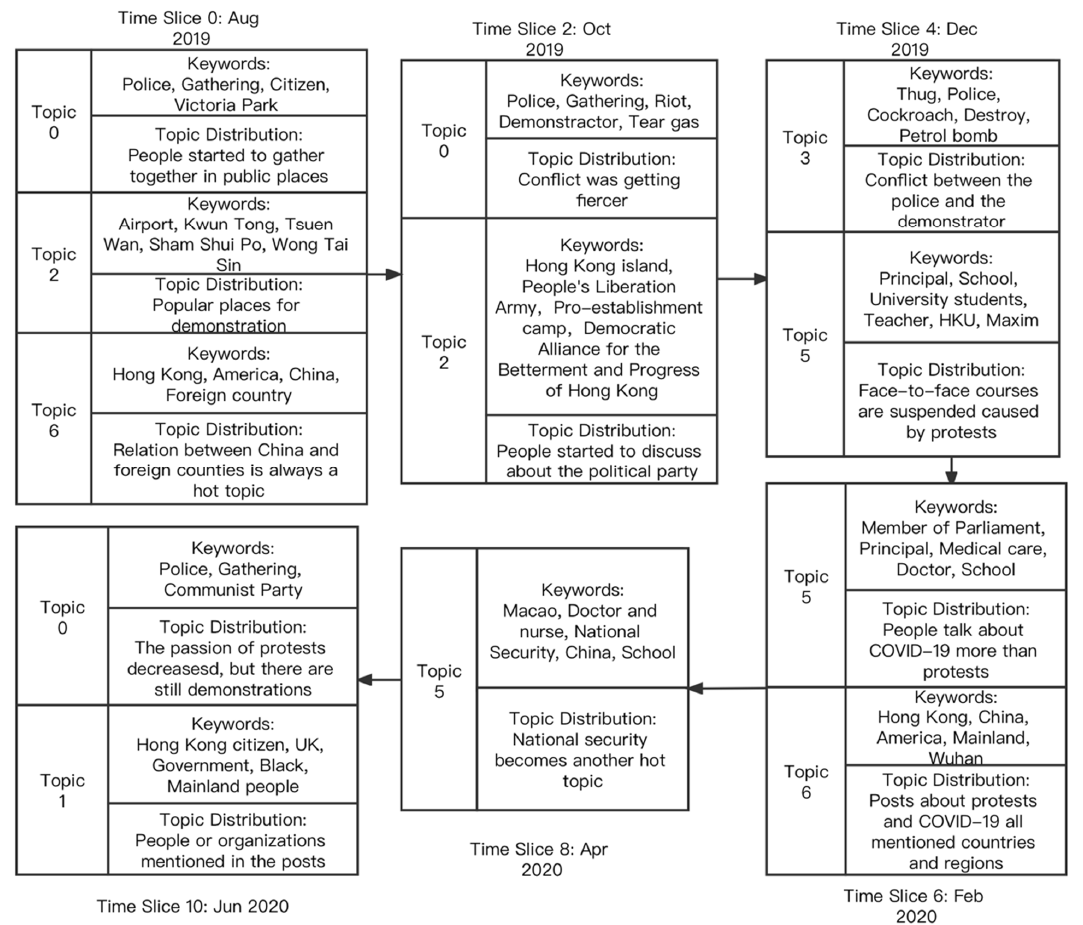
Figure 6. Trend of topic evolution in different time slices.